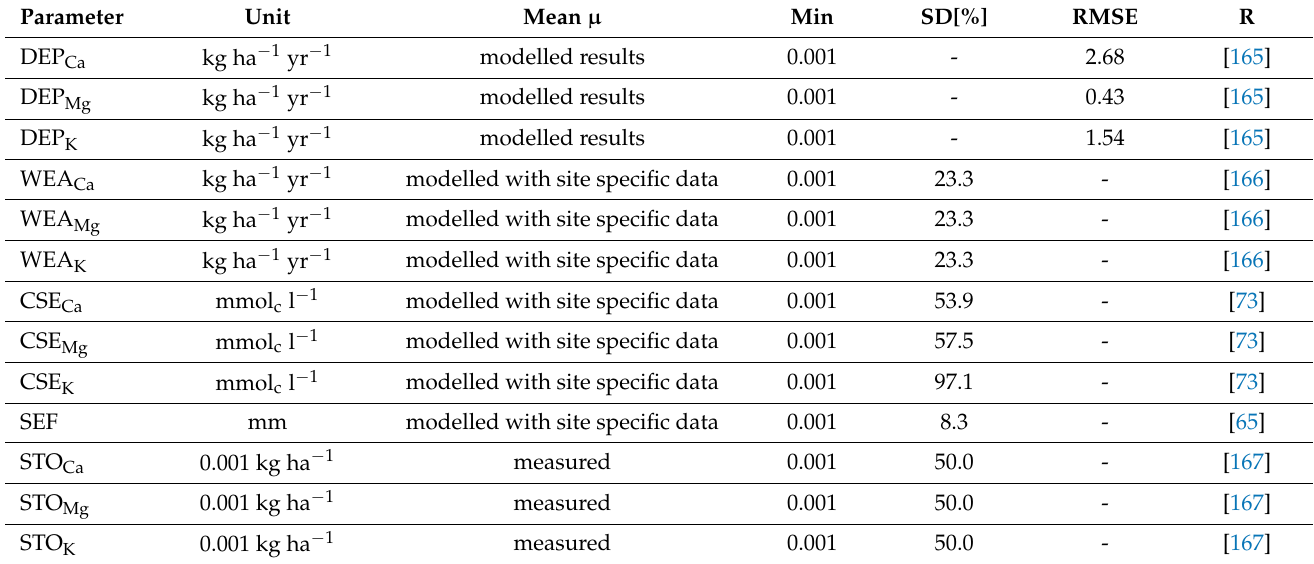
Table A3. Input data and uncertainty ranges of the balance variables as the basis for the Monte Carlo simulations of the soil balances components on the NFSI points. DEP: deposition; WEA: weathering rate; CSE: concentration in seepage water; SEF: seepage flux; STO: soil stock of plant available nutrients; mean µ : site mean; min: minimum value; SD: standard deviation; RMSE: root mean square error; R: data reference.